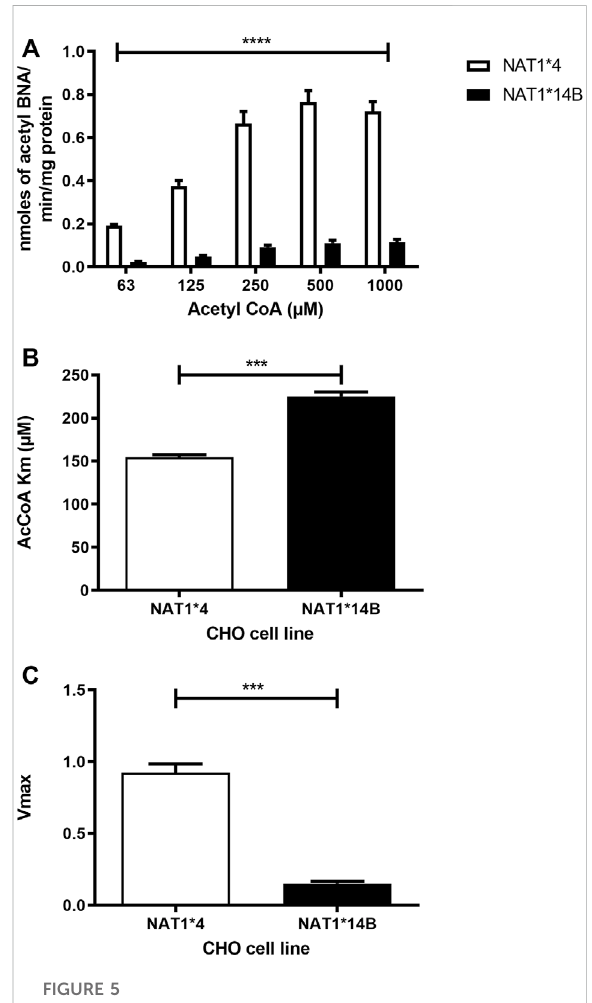
FIGURE 6 (A) Effect of NAT1 alleles on in vitro N -acetyltransferase catalytic activities towards benzidine using AcCoA (62.5 – 1,000 µM). (B) Apparent AcCoA K m is higher in